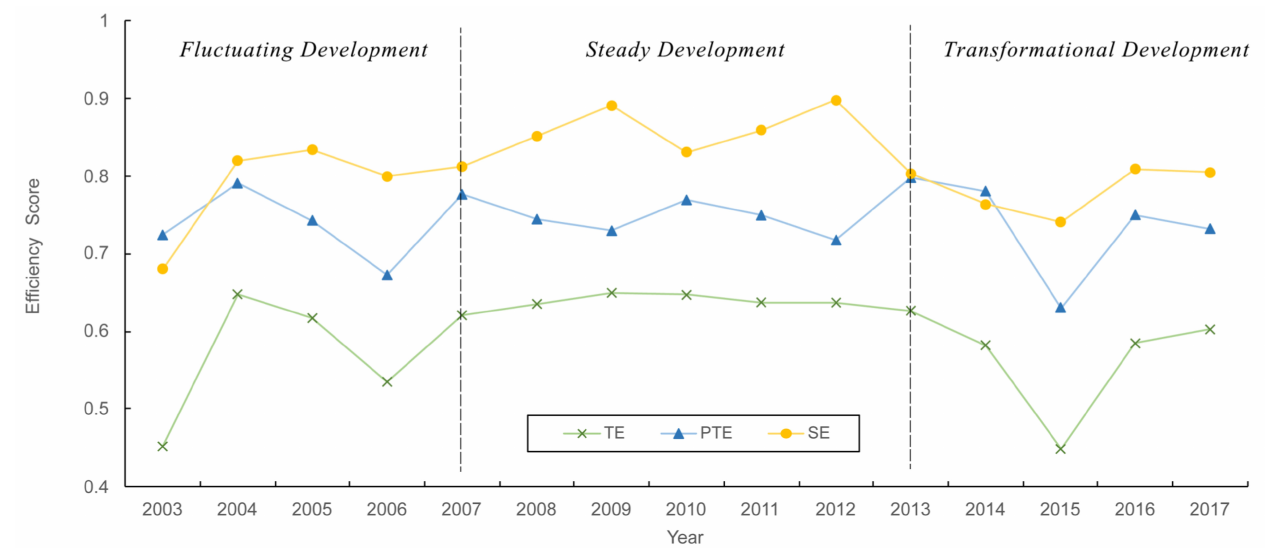
Figure 6. Three stages of mass tourism destinations in